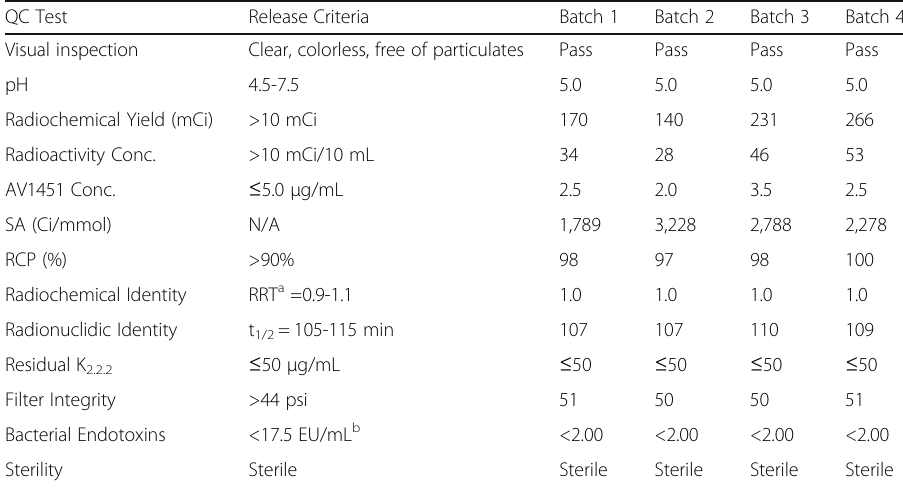
Table 1 QC Data for Process Verification Batches of [ 18 F]AV1451 QC